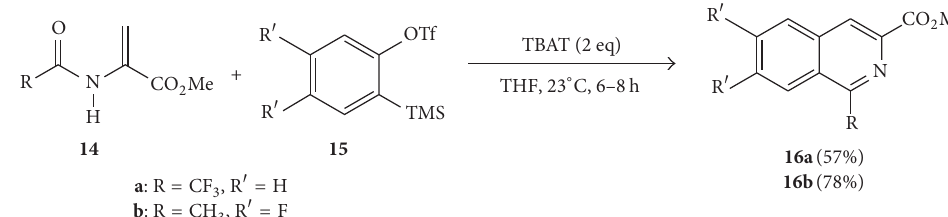
Scheme 5: 6,7-Difluoro- and 1-trifluoromethylisoquinolines via aryne